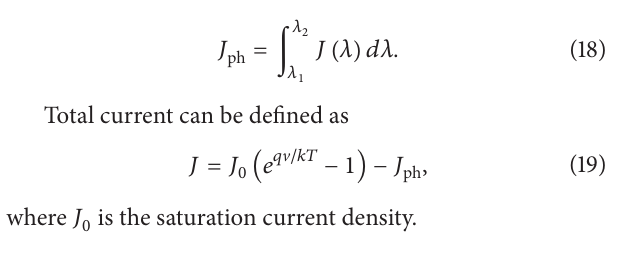
The calculations are done without considering trapping. Total